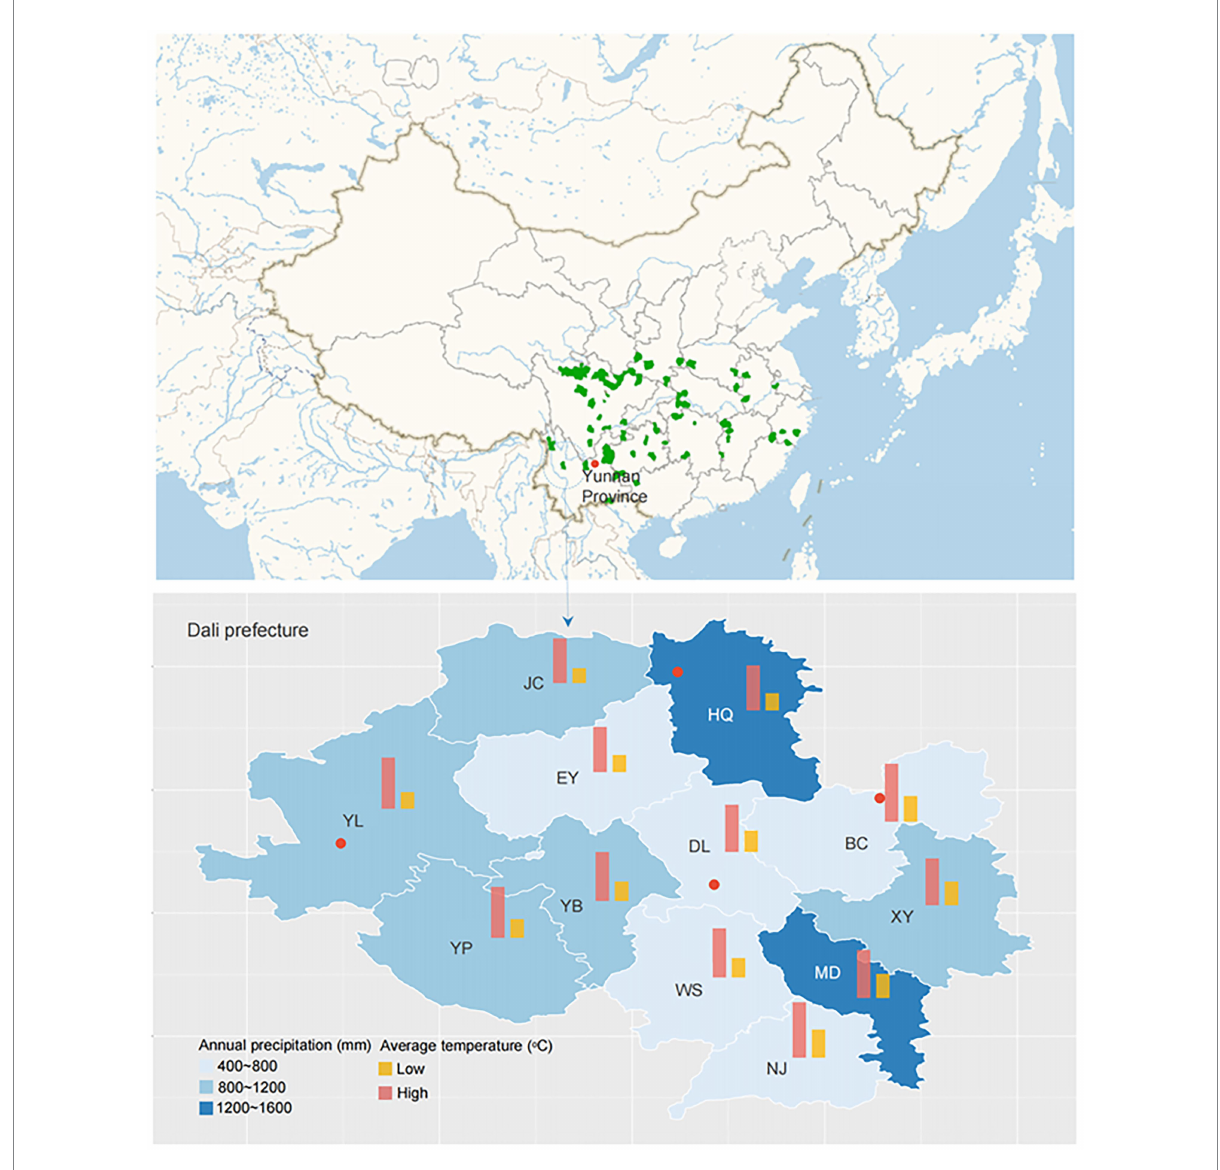
FIGURE 1 Localization of the sampling sites (the red points represent the collection place: YL, BC, HQ, and DL).